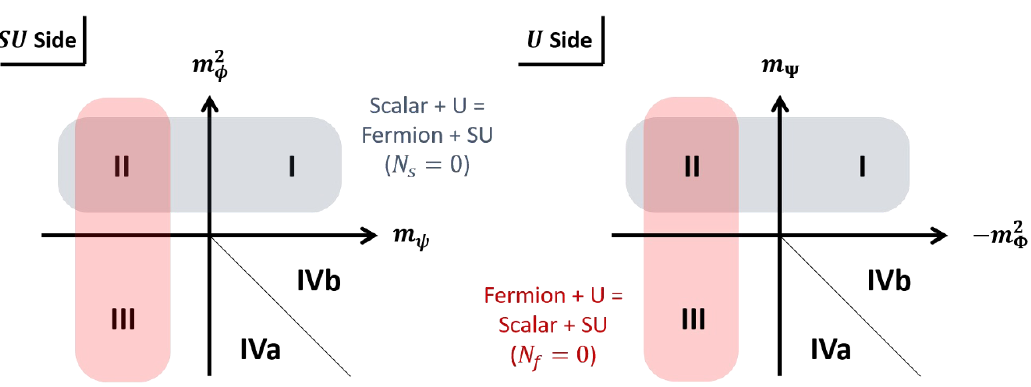
Figure 1 . Various phases of the master duality and the non-Abelian reductions. The shaded red and blue correspond to the single-matter non-Abelian